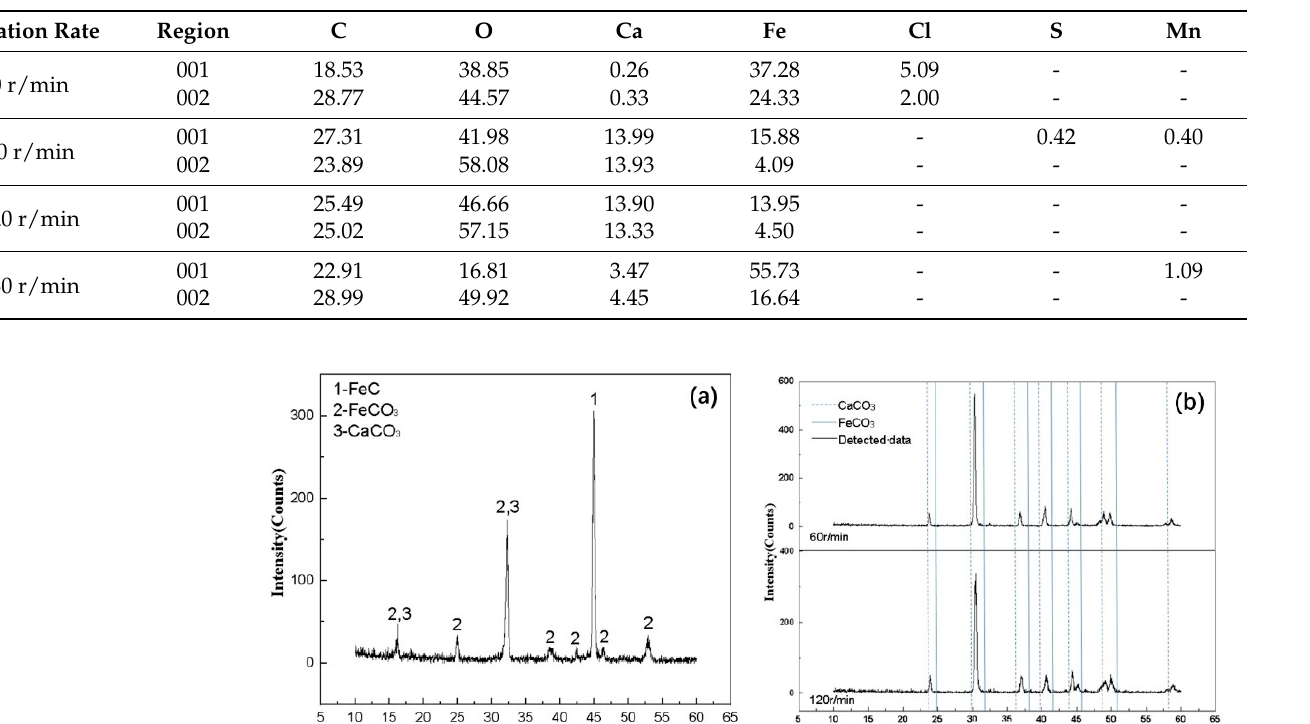
Table 4. EDS results of corrosion products on the sample surface at different rotational speeds.